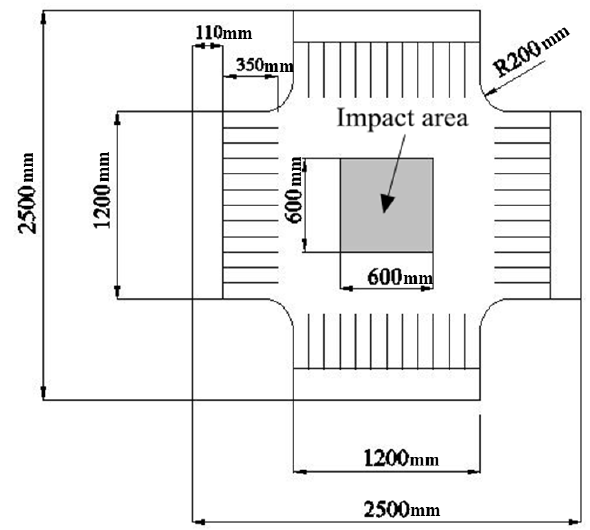
Figure 8. Illustration of experimental samples and impact area.